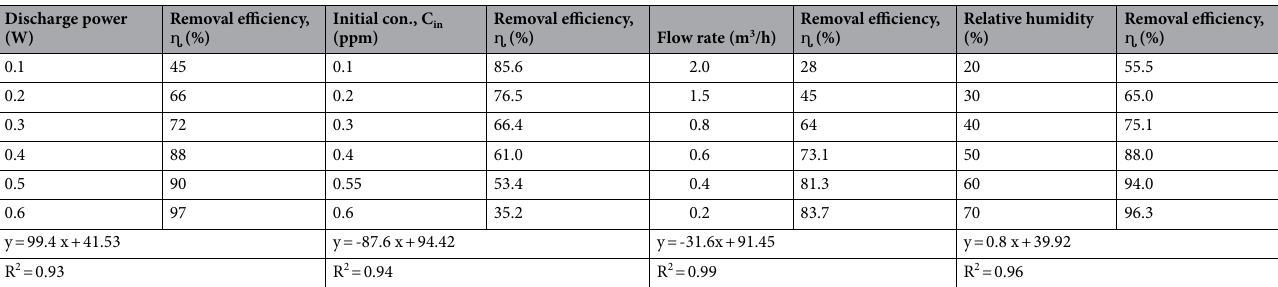
Table 4. Statistical effect of different processing conditions the removal